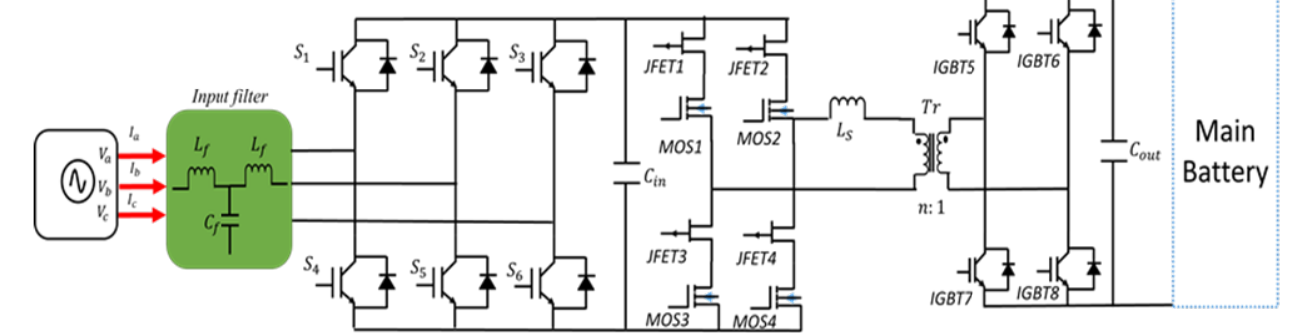
Figure 1. Three-phase on-board charger topology based on active rectifier and single DAB.